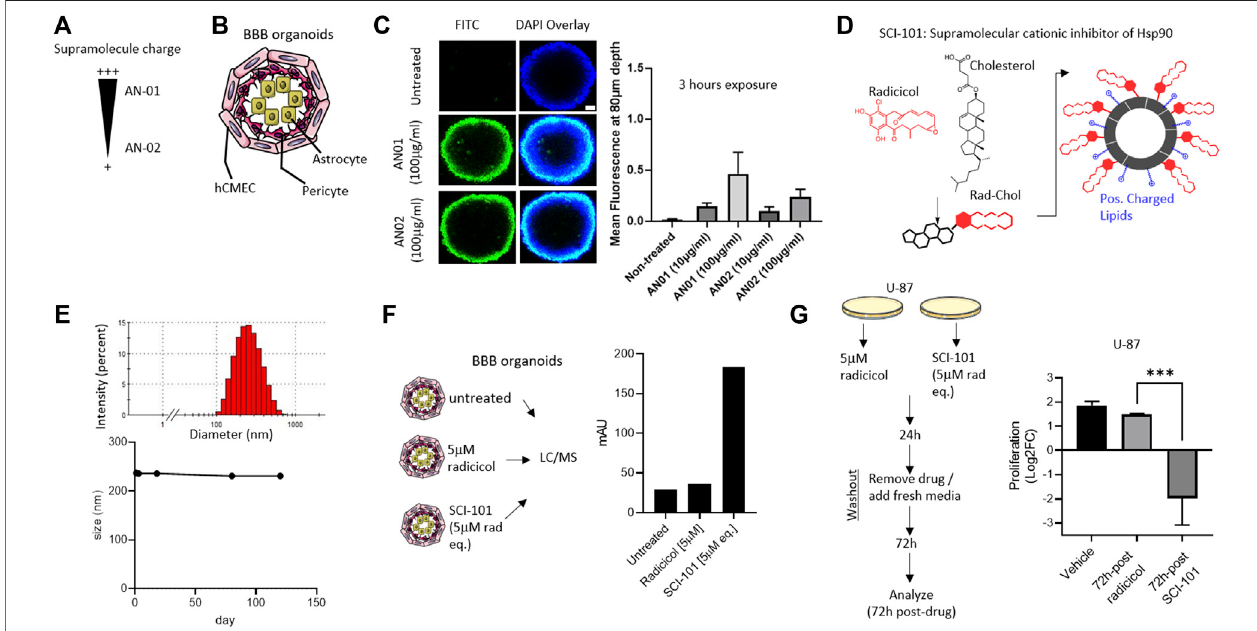
FIGURE 2 | Design, synthesis, and characterization of a BBB organoid – penetrating supramolecular cationic inhibitor of Hsp90. (A) The schematic shows the designofsupramoleculardrugvehiclesusinglipidswithvaryingheadgroupcharge:AN01andAN02. (B) TheschematicdepictstheBBBorganoidmodelusedforinvitro experiments. The endothelial cell layer (hCMEC) surrounds the pericyte and astrocyte layers of cells. (C) The immuno fl uorescent image shows in fi ltration of AN01 and AN02 into the BBB organoid. The green signal indicates the amount of lipid penetrating the endothelial barrier deep enough to account for passage into the BBB organoid (80 μ m). Scale bar (cid:2) 50 μ m. The right panel quanti fi es the fl uorescent intensity at a depth of 80 μ m. (D) The schematic shows the design of SCI-101, comprising cholesterol-radicicol conjugates assembled together with positively charged lipids into a supramolecular structure. (E) The representative histogram shows the size distribution of SCI-101 (upper panel) and longitudinal trace of average size over 120 days to demonstrate stability of the drug vehicles (lower panel). (F) The schematicdescribestheexperimentaldesignforquali fi cationofradicicolintheBBBorganoid.Therightpanelbargraphquanti fi esthepenetrationofradicicolfreedrugor SCI-101 in fi ltrated into the BBB organoid as measured by the area under the curve. (G) Experimental design schematic for drug washout studies. Following 24 h exposure to either free drug radicicol or SCI-101 at equivalent concentration (5 μ m), the cells were washed and recovered with fresh media for 72 h. The right panel histogram quanti fi es the proliferation of U-87 cells 72 h after drug washout. The values shown are relative to the number of cells prior to drug washout in the vehicle control group. ***p < 0.001 by ordinary one-way ANOVA with Tukey ’ s multiple-comparison test.